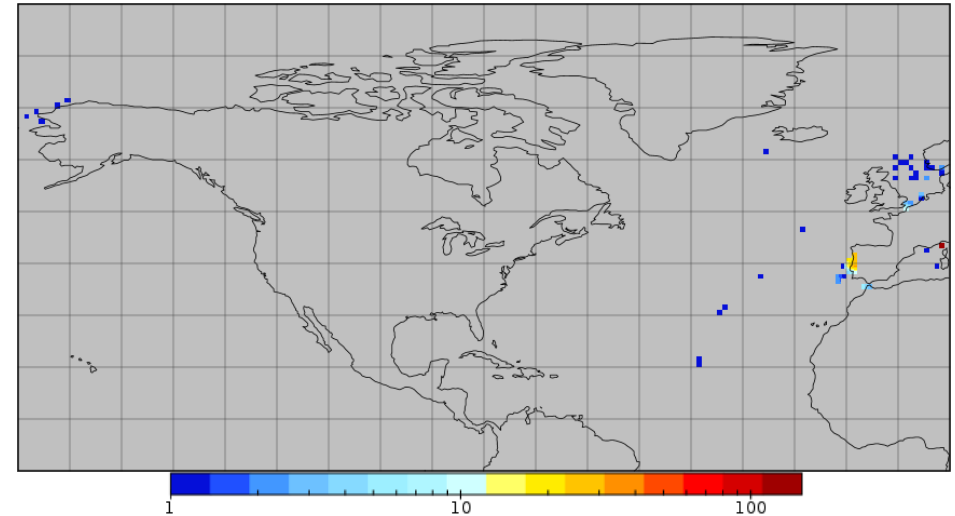
Figure 1. The distribution of data used in the matchups database. The map shows the number of matchups in each 1° × 1° cell. matchups in each 1 ◦ × 1 ◦